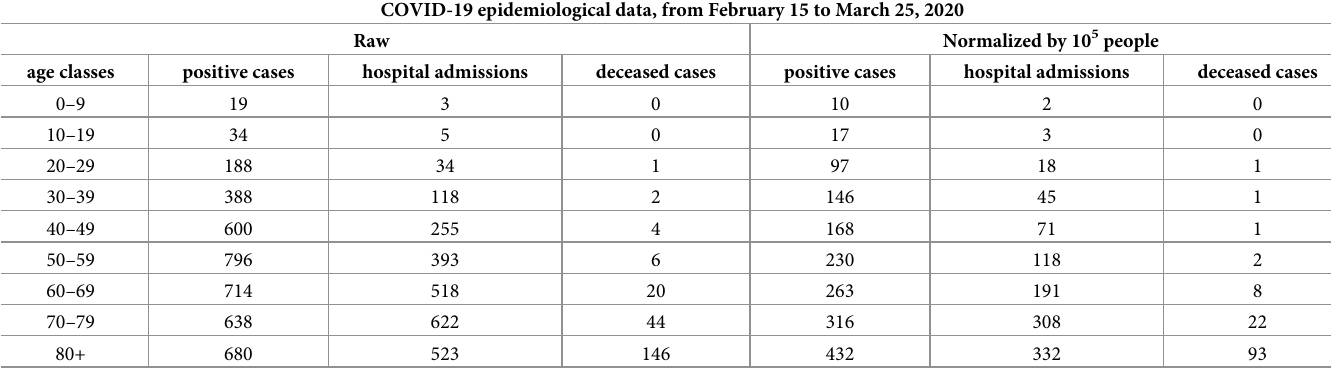
Table 3. Cumulative disease cases by age in the Basque